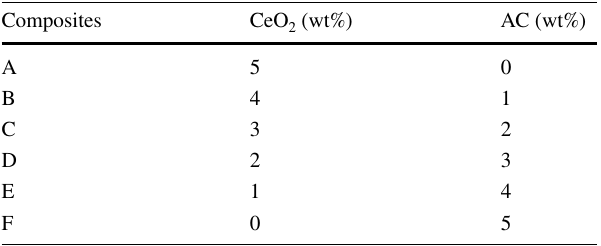
2 in the composites